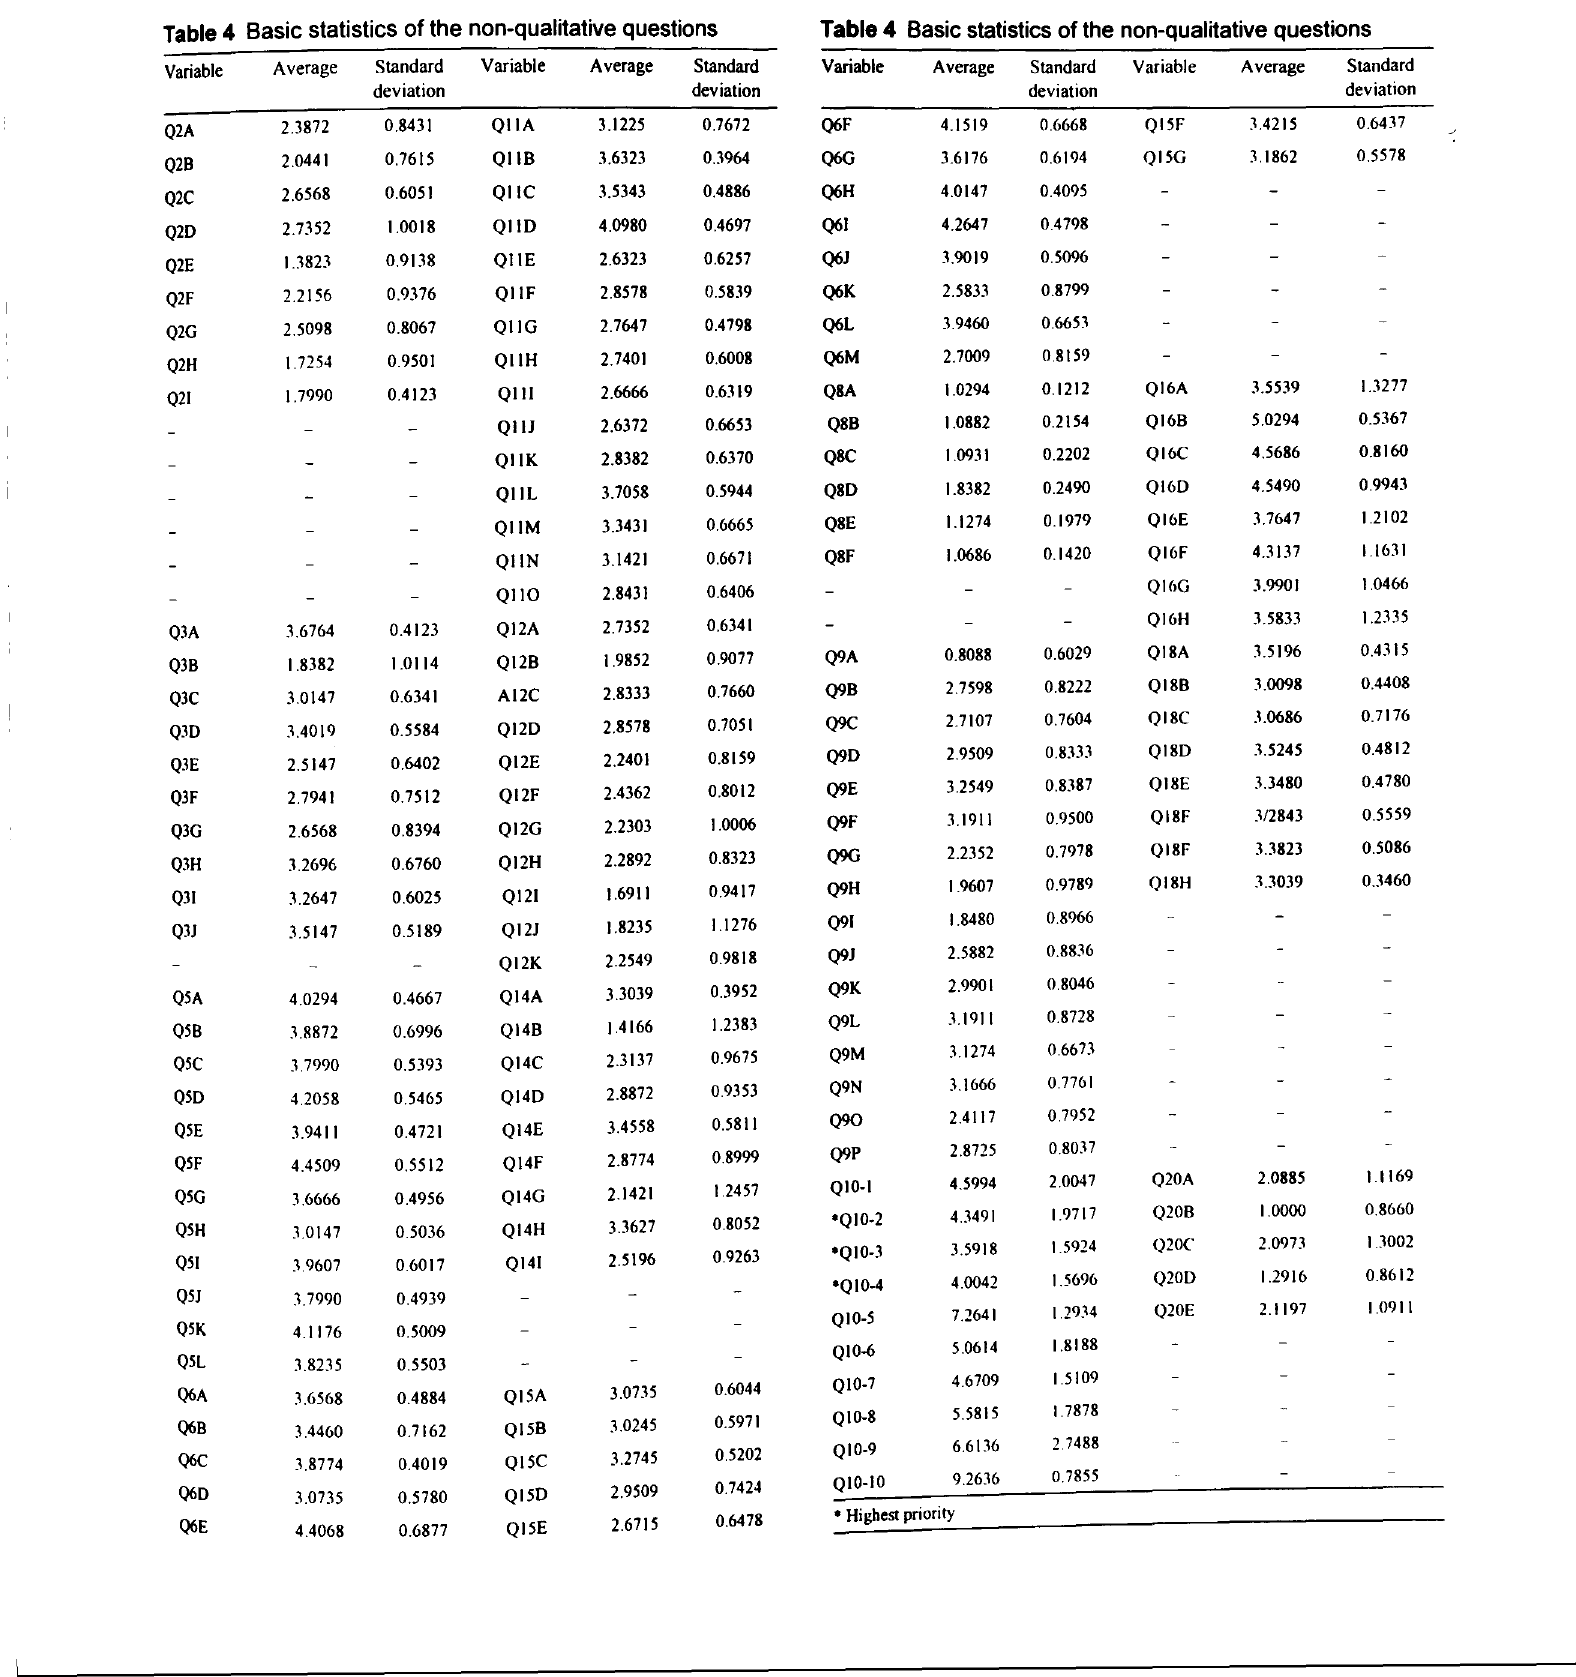
Table 4 Basic statistics of the non-qualitative questions